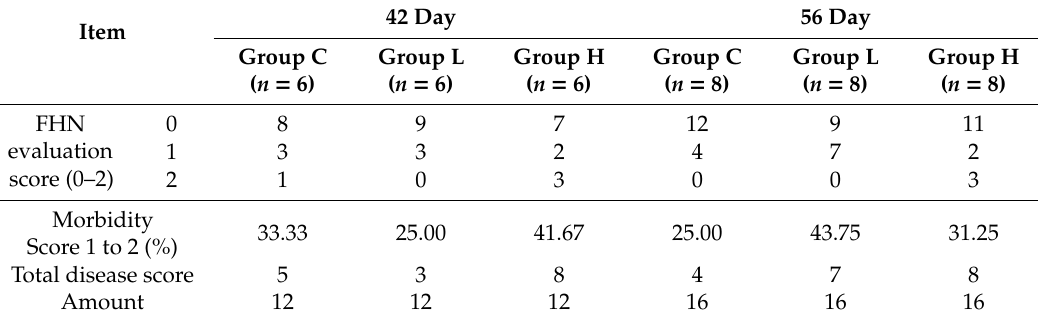
Table 2. Femoral head necrosis (FHN) evaluation and morbidity in broilers, both legs of each broiler were